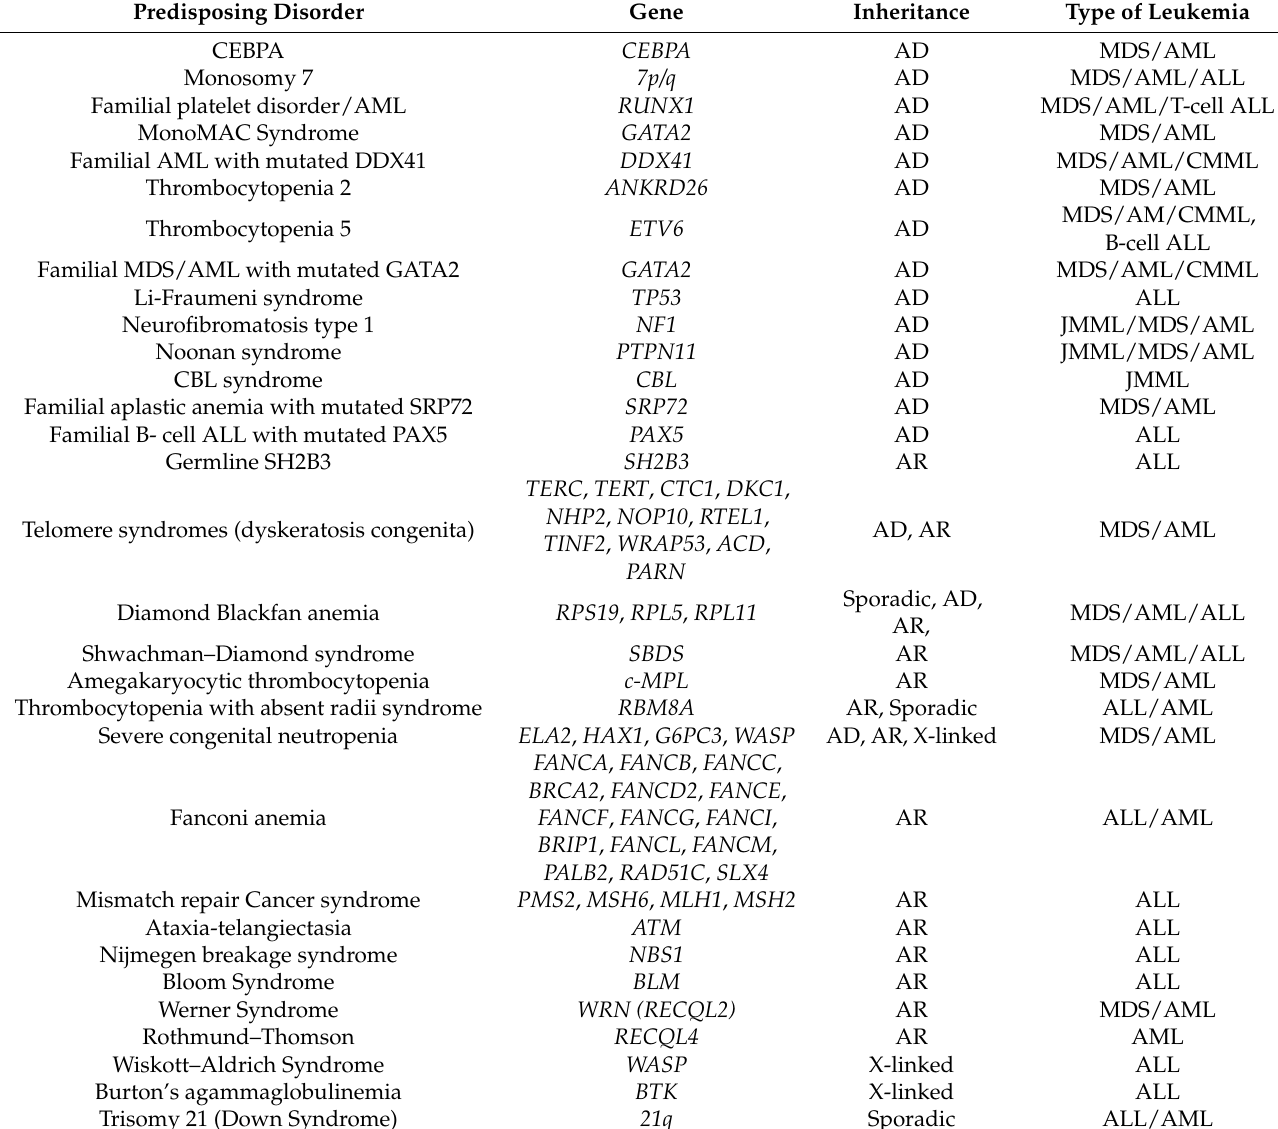
Table 1. Inherited predisposing syndromes to hematologic